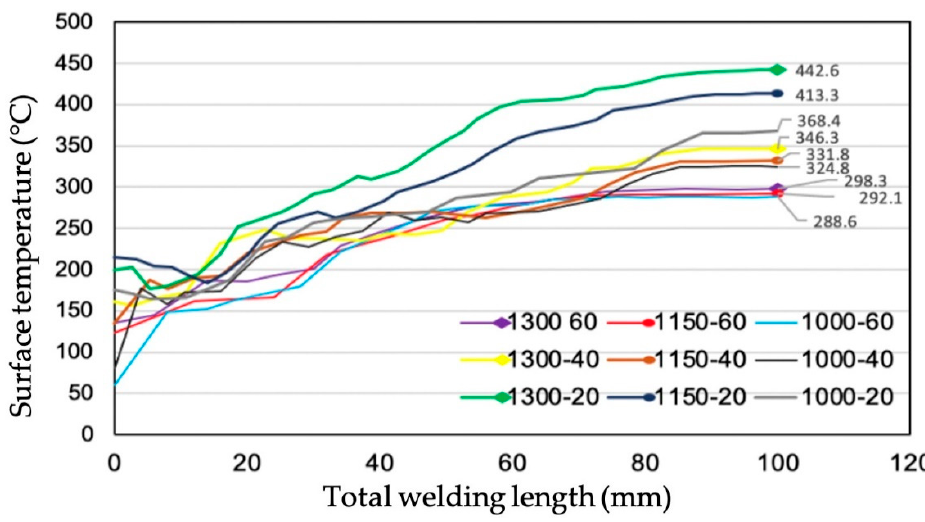
Figure 6. Temperature profile as a function of the welding length.